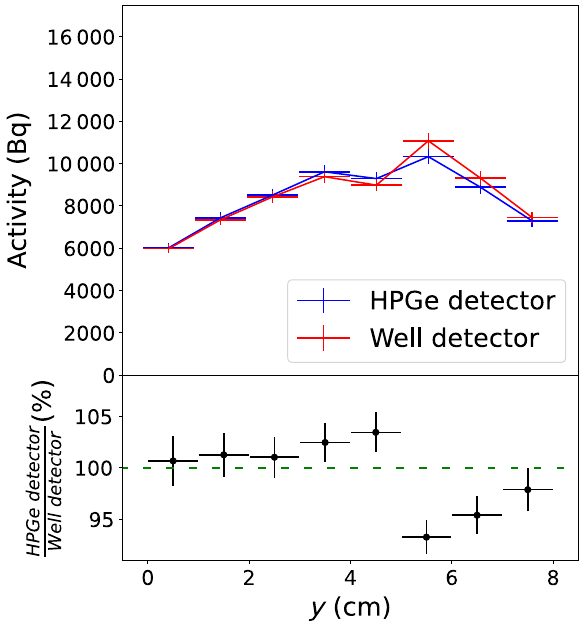
plotting.FIG. 9. Comparison of Rod 1 activity measurements performed at UIUC, using an HPGe detector (Sec. IV C), and ANL, using a well-type detector (Sec. IV D). The origin of the horizontal axis ( y ¼ 0 ) corresponds to the bottom edge of the rods in Fig. 3, located 3.7 cm below the LHC machine axis. The errors on the abscissa represent the half-length of the samples. The bottom panel shows the ratio between the two measurements. A dashed green line that corresponds to unity is drawn for direct compari- son. Please note that there is an additional 3.3% correlated uncertainty on the calibration source activity that is not included in the ratio uncertainties. Results have been normalized to